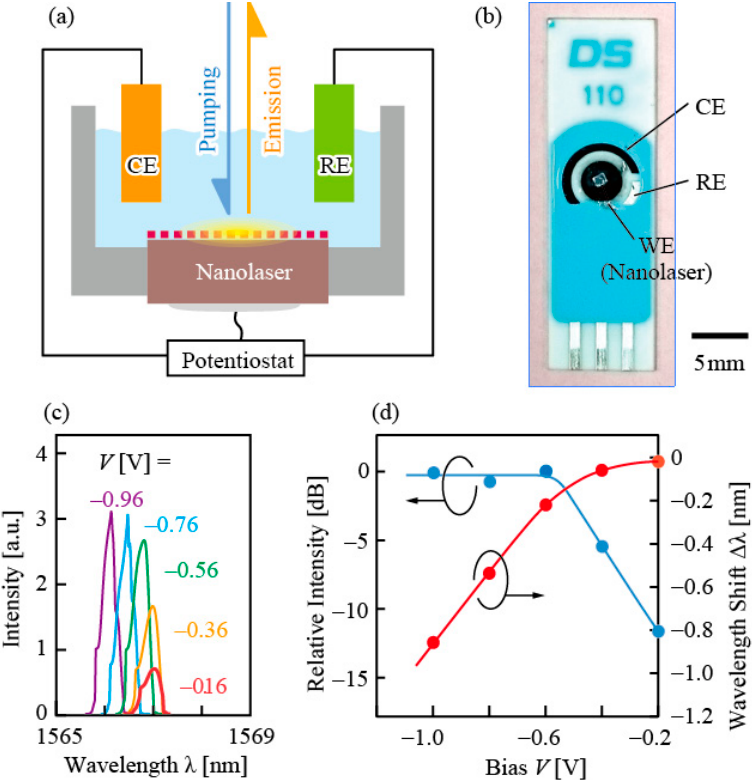
Figure 13. Electrical control of emission intensity and wavelength of GaInAsP nanolaser in photo- electrochemical circuit. ( a ) Configuration of the circuit. CE and RE denote counter and reference electrodes, respectively. ( b ) Screen print cell used as the circuit. WE denotes a working electrode. ( c ) Emission spectrum for different bias voltages V . The V value was calibrated by Ag/AgCl standard electrode. ( d ) Dependency of emission intensity and wavelength on bias voltage. For ( c ) and ( d ), pH was set at 8.